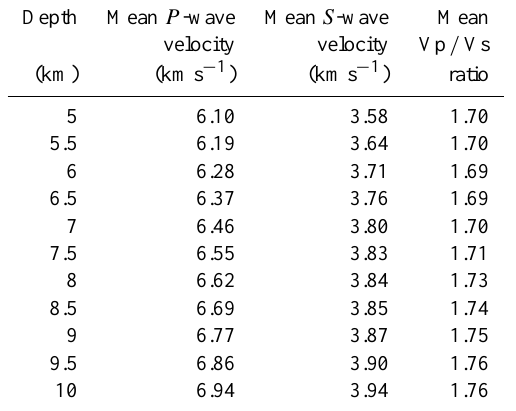
Table 1. Average seismic velocities within the Nový Kostel focal zone calculated from the weighted average model (WAM).